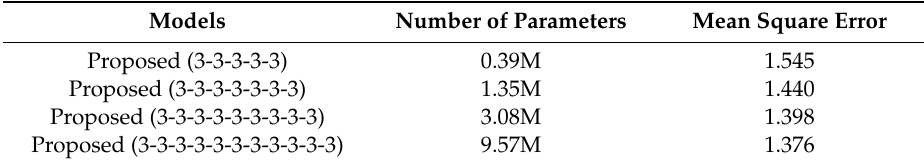
Table 2. Performance comparison of di ff erent network layers.